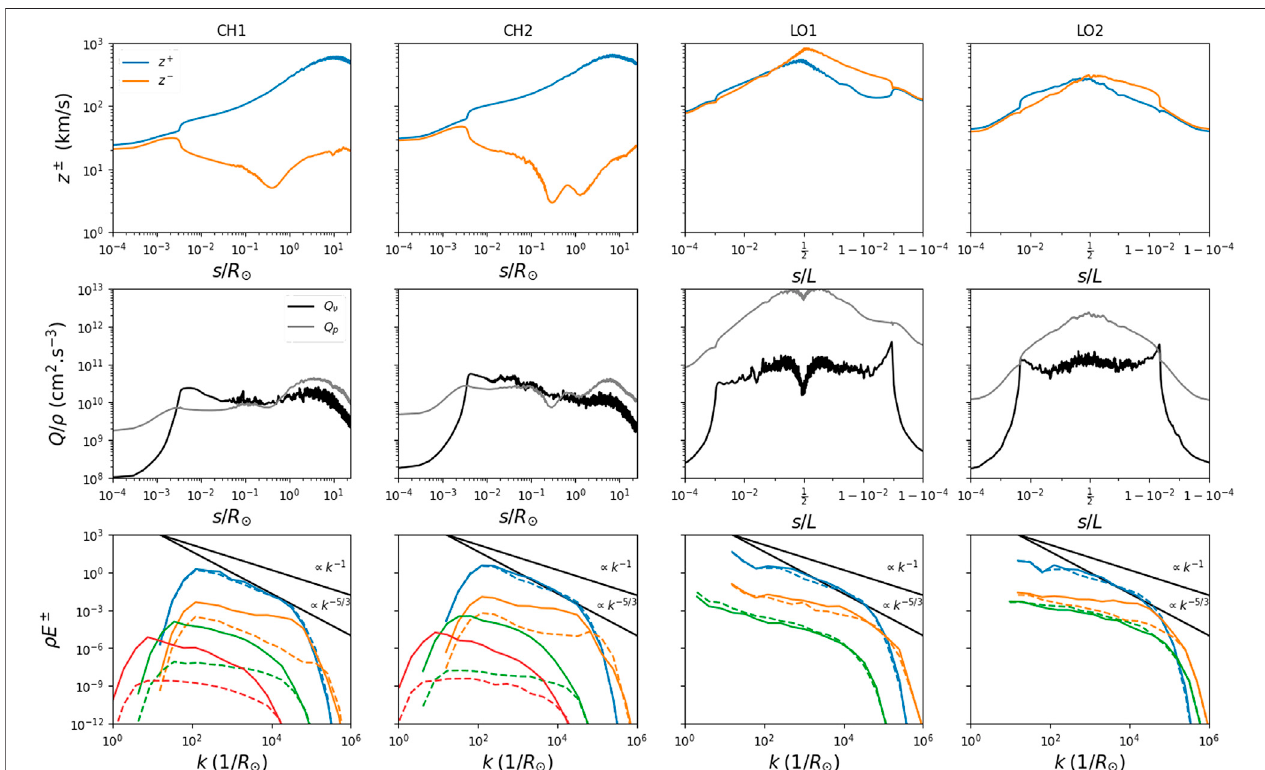
FIGURE 3 | Overview of shell simulations A with the same input parameters on the four geometries of coronal holes and loops. The top panel shows the time averagedrms fl uctuations z ± .Forcoronalloopcases,thecurvilinearabscissa s isnormalizedby L thelengthoftheloopandbothboundariesareshowninlogscale.The middlepanelshowstheheatingobtainedbydissipationatsmallscales Q ] inblackandcomparesitwithaphenomenologicalform Q p .Thelastpanelgivesthespectraof the fl uctuations( + inplainlines, − indashedlines)atvariousdistancesoftheSun.Foropenregionssimulations,theblue,orange,greenandredlinescorrespondsto r (cid:1) 1 . 001 , 1 . 01 , 2 . 5 and 10 R ⊙ respectively. For coronal loops, the blue and orange remain the same, while the green lines are the spectra at the apex of the